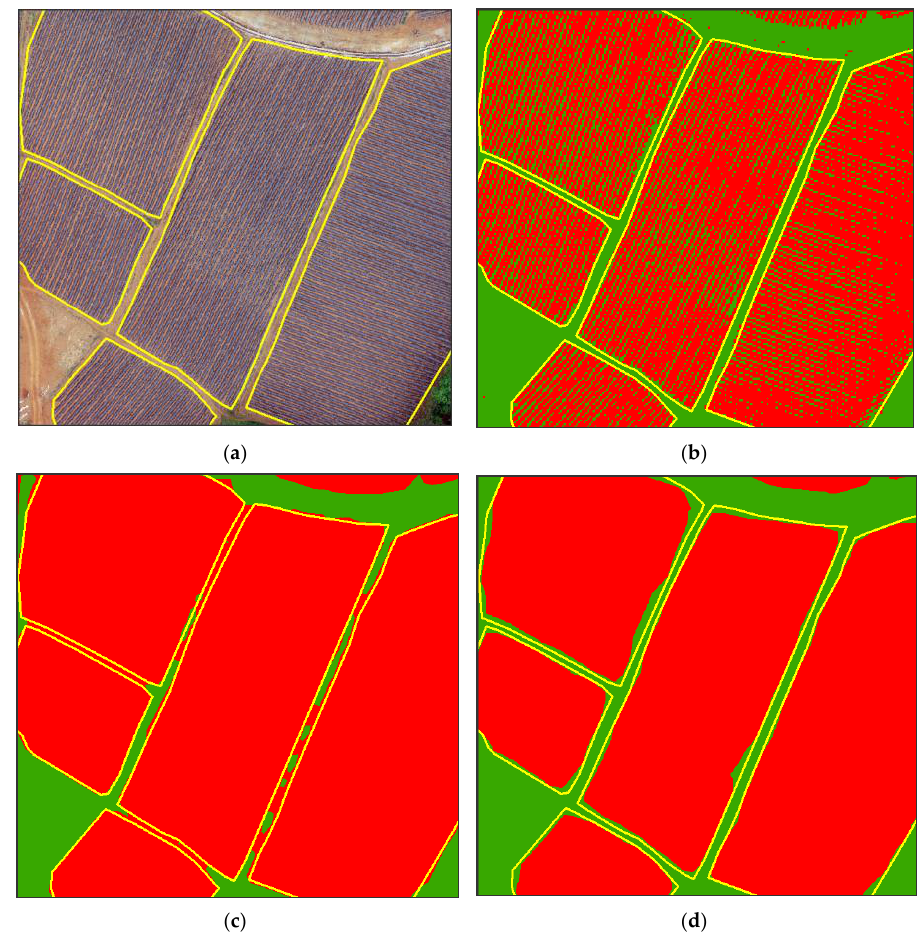
Figure 7. The impact of convolution on tobacco field recognition accuracy. ( a ) Original image; ( b ) binary map; ( c ) morphology; ( d ) combining morphology with convolution.